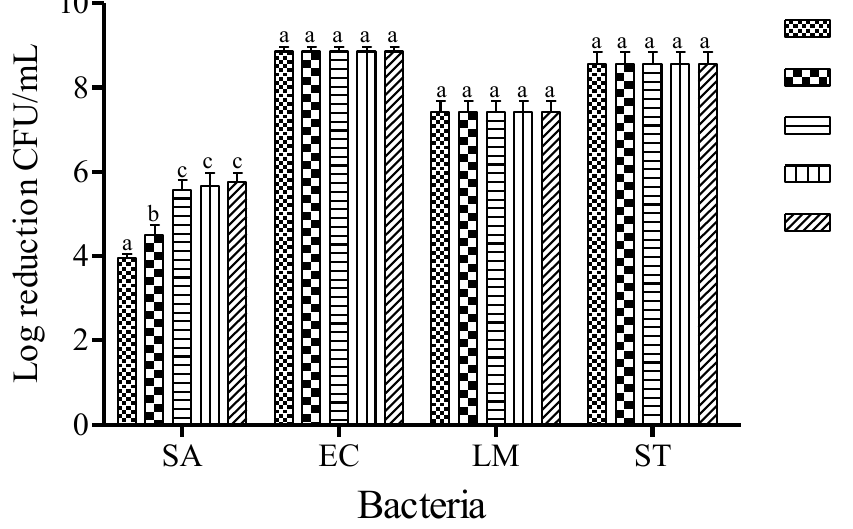
Figure 1. Inactivation of different foodborne pathogens treated with fumaric acid (0.25%) for 1 min at different temperatures. Vertical bars represent means of three replications ± standard deviation. Bars labeled with different letters indicate significant differences at p <